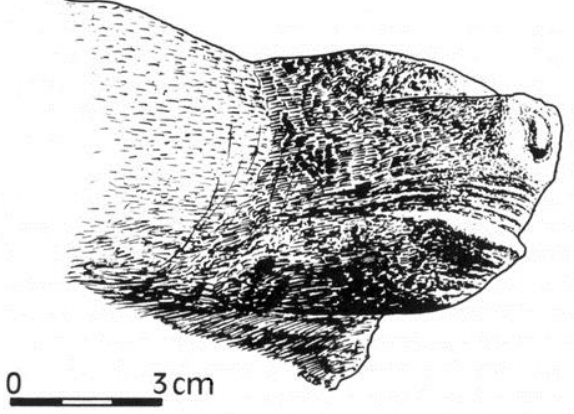
Figure 9. Presumed head of a bear carved on a woolly rhinoceros vertebra from Tolbaga, south of Lake Baikal, Siberia, probably about 35,000 years